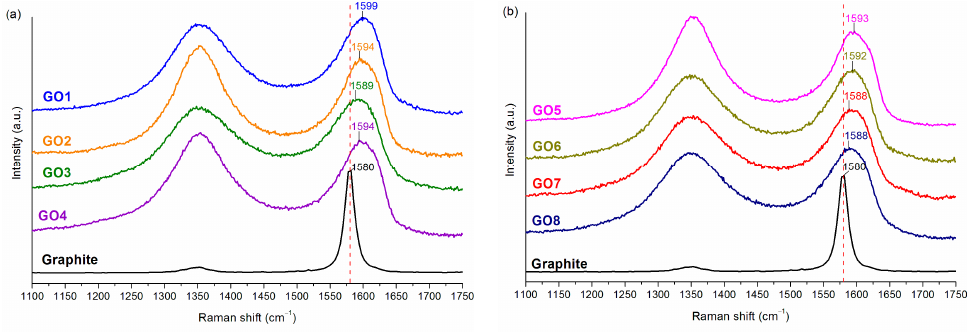
Figure 2. ( a ) Raman spectra for graphite and for GO1–4; ( b ) Raman spectra for graphite and for GO5–8.